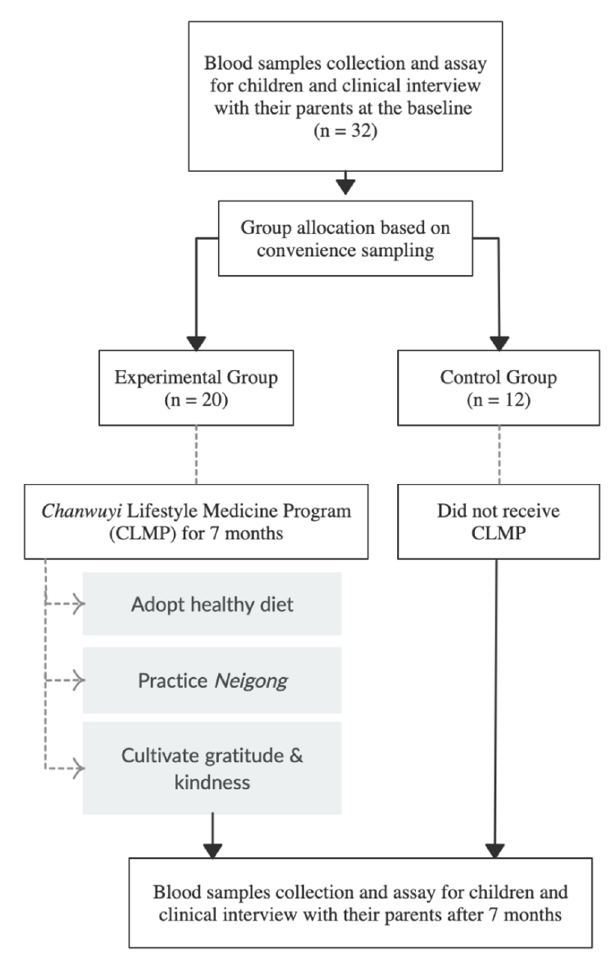
Figure 1. Flow of experimental procedure.